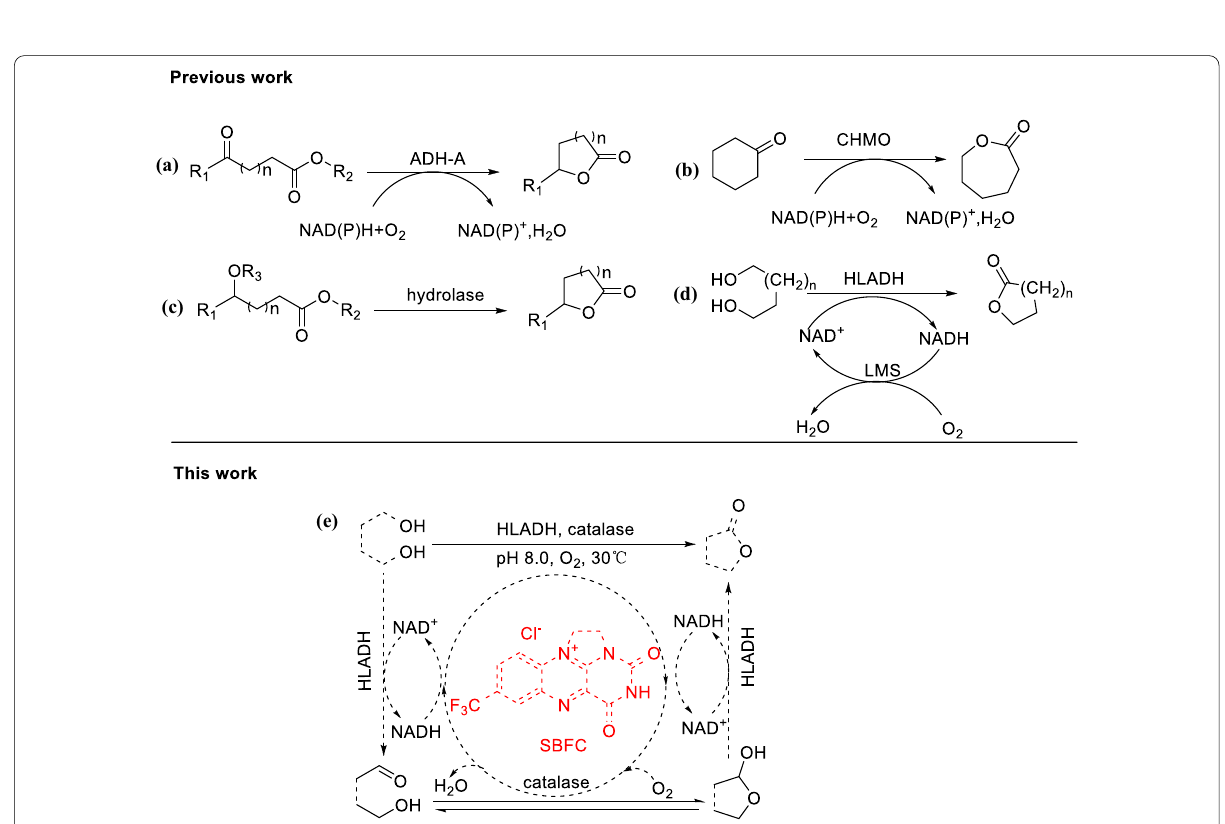
Fig. 1 Types of compounds derived from lactone